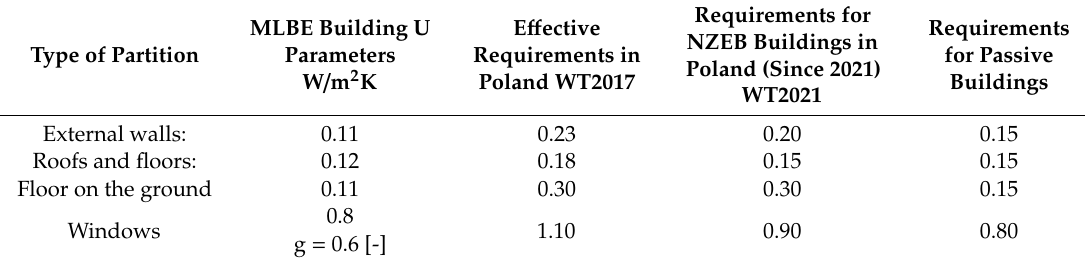
Table 1. Heat-transfer coefficient U W/(m2·K) for Energy-Efficient Building Laboratory of Lesser Poland (MLBE) building, requirements according to Polish regulations [3] and requirements for passive buildings [4].